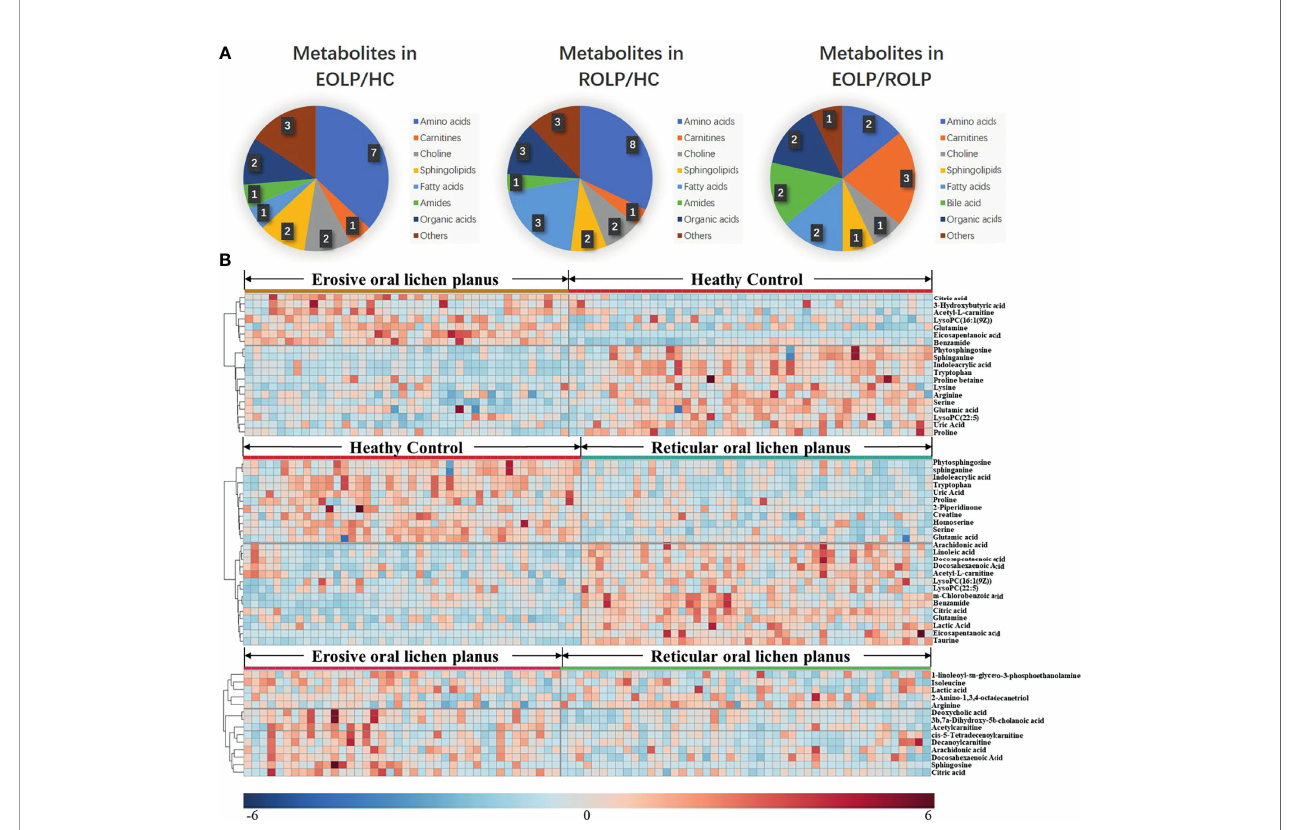
FIGURE 4 | The pie chart shows the distribution of different metabolites (A) . The heat map analysis of endogenous metabolites in the EOLP group and healthy group, ROLP and HC group, EOLP group and ROLP group (B)